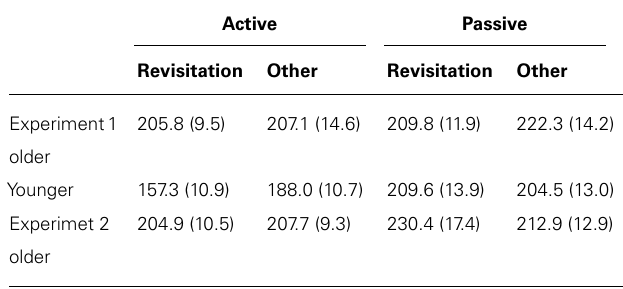
Table 2 | Mean and standard error for object recognition discrimination sensitivity ( d (cid:3) ) for objects studied with revisitation versus other-studied objects in Experiment 1 and Experiment 2.